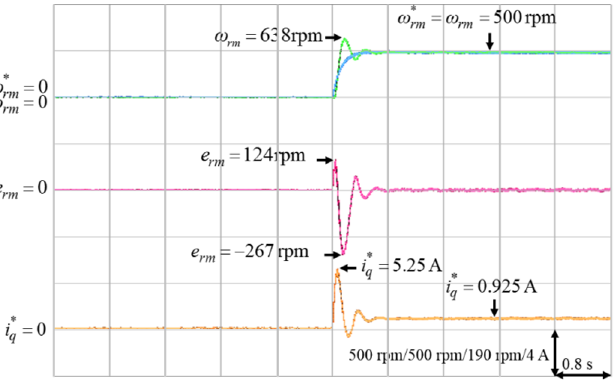
Figure 5. Experimental results of ACSM speed controller from standstill to 500 rpm in Case 1.